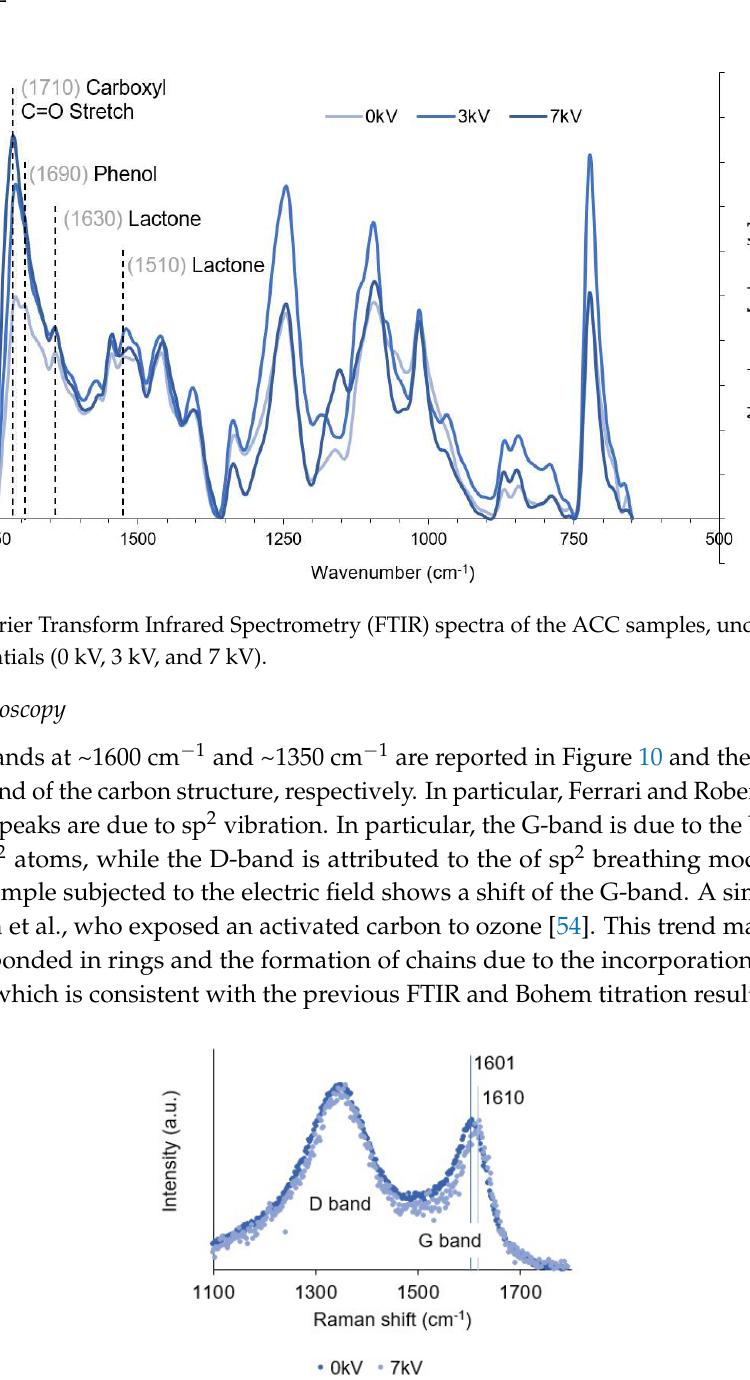
Figure 10. Raman spectra of the ACC samples, with and without the applied electric field.